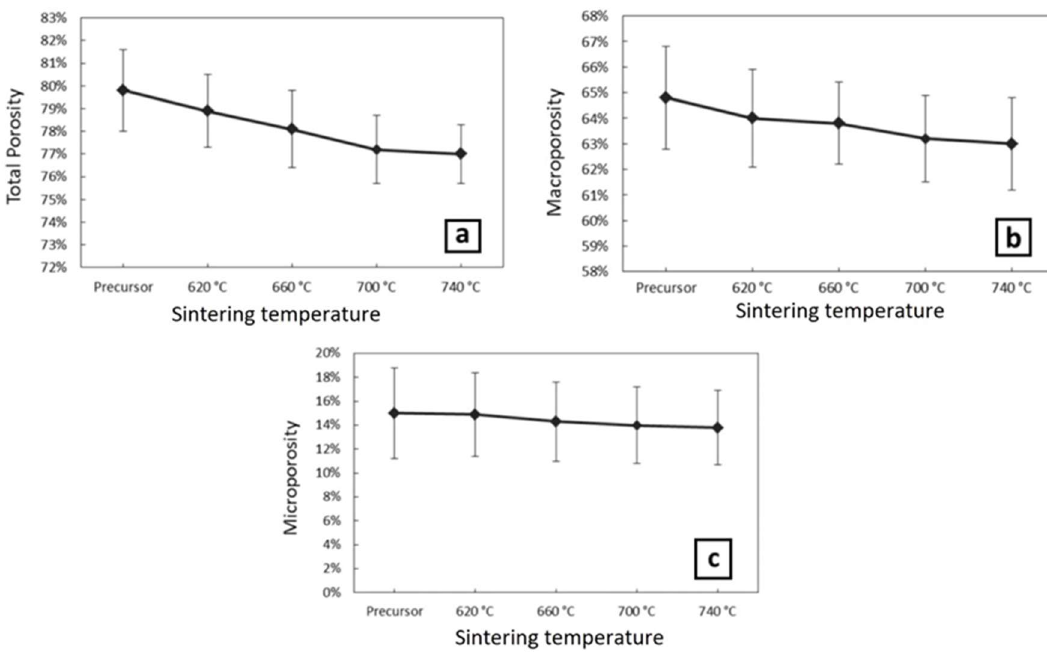
Figure 5. ( a ) Total porosity measured using Equation (1), ( b ) macroporosity measured using theopen source scientific image processing program, ImageJ, ( c ) microporosity calculated by subtracting the macroporosity from the total porosity.